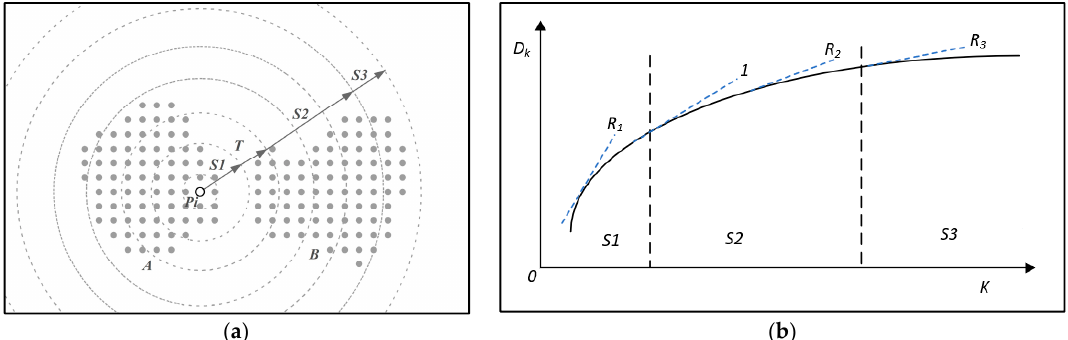
Figure 3. Analysis of the three stages of point P i ’s neighbor points. ( a ) Three stages and the turning point; ( b ) Tangent slopes for three stages and the turning point